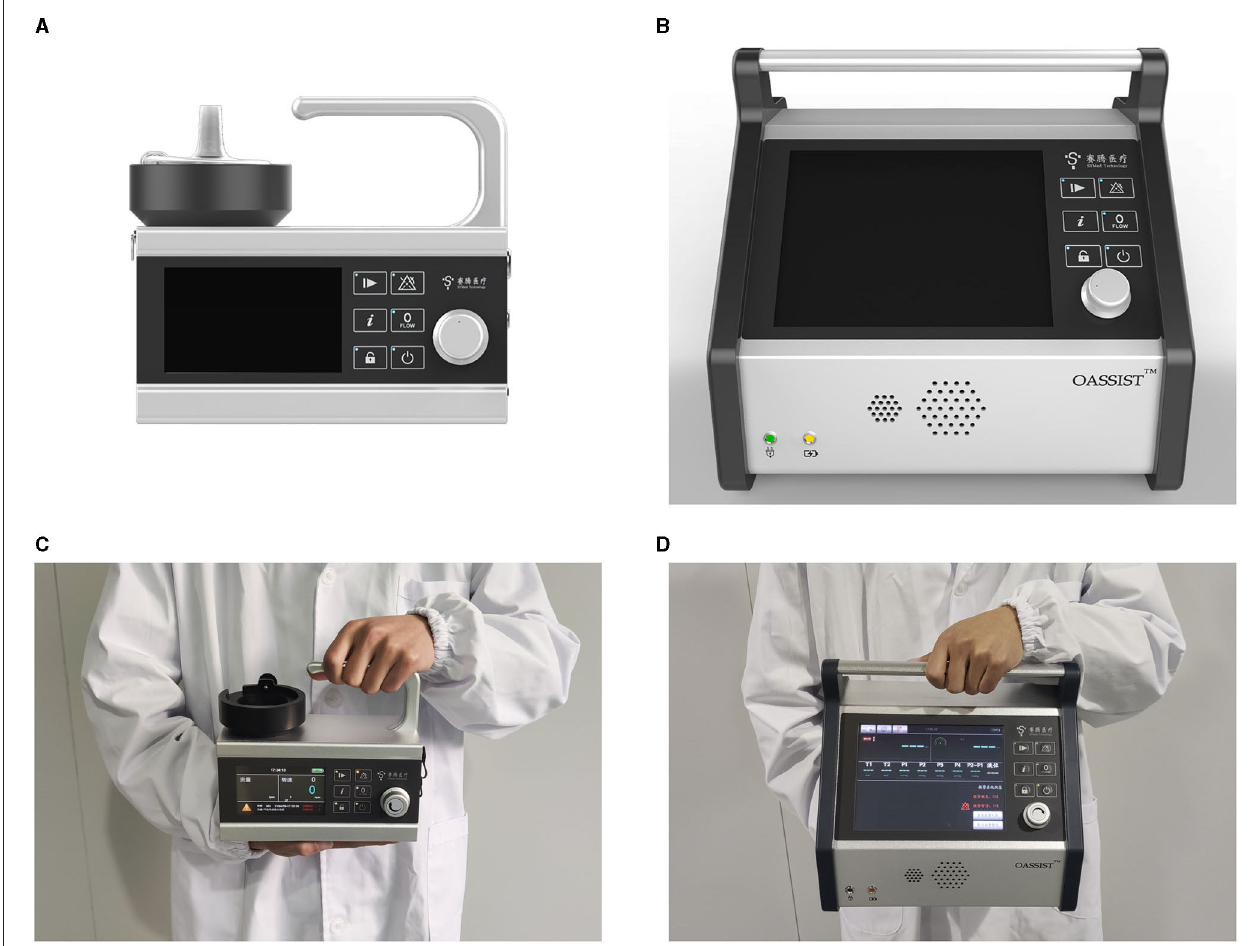
FIGURE 1 | Macro-inspection the OASSIST ECMO system. (A) The macro-inspection of the pump drive. (B) The macro-inspection of the control console. (C) The pump drive hold by a staff. (D) The control console hold by a stuff.